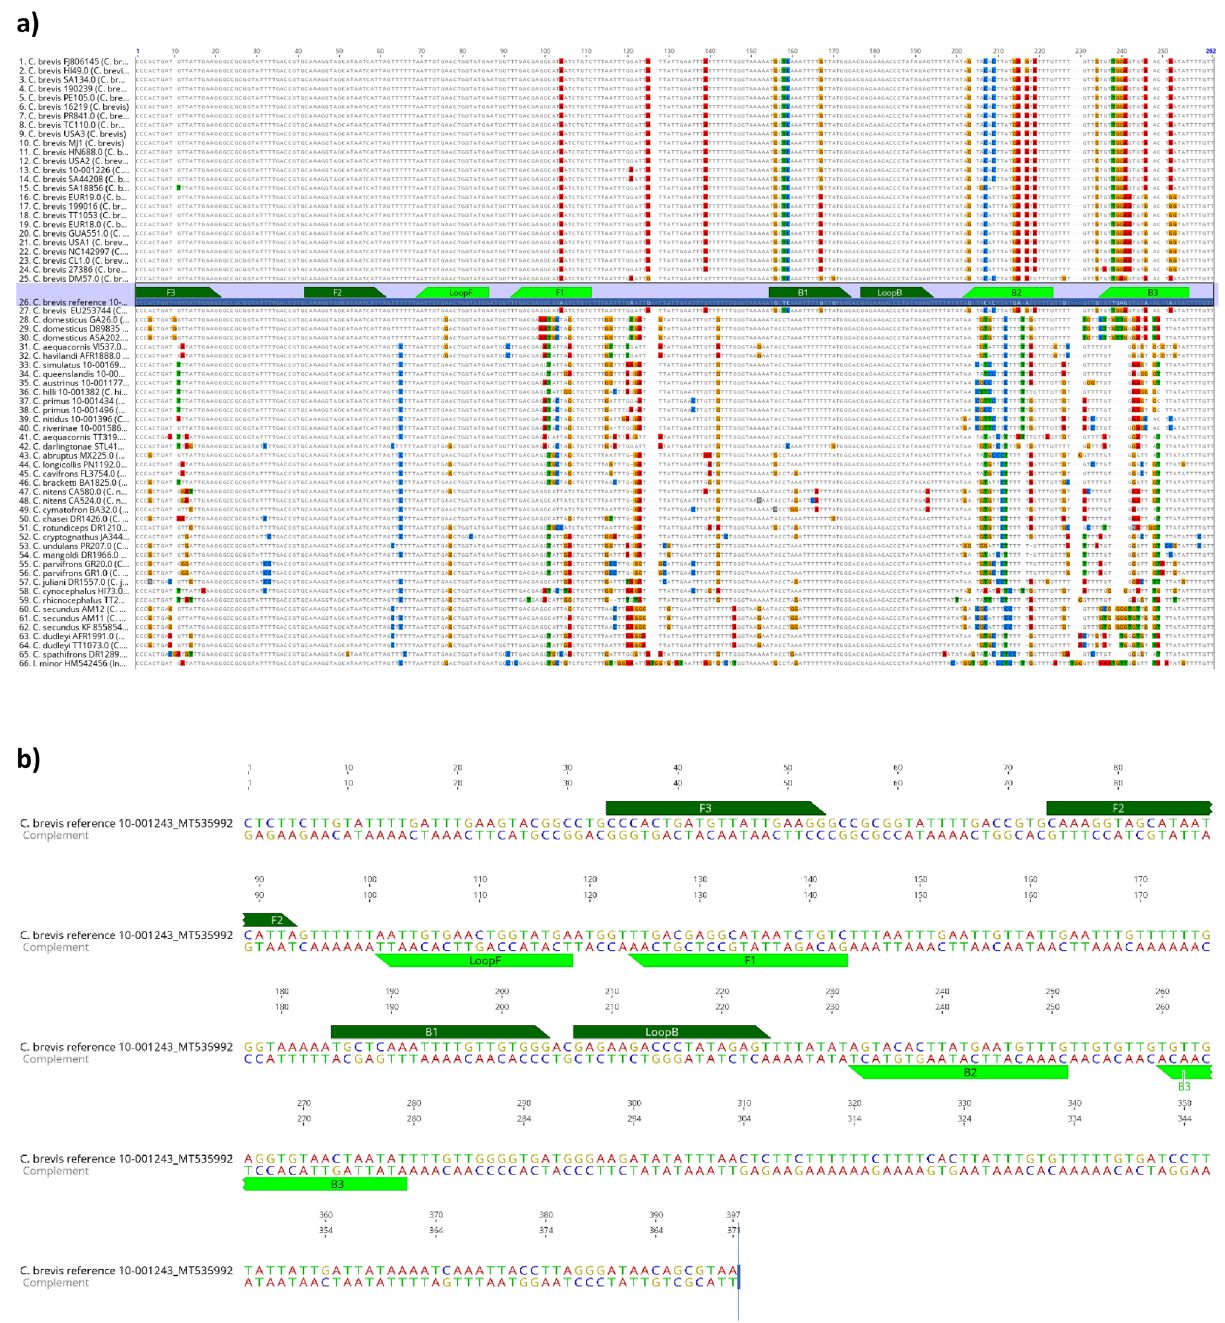
design. ( b ) The reference sequence C. brevis MT535992. Inner primer, FIP, consists of F1 (complementary sequences) and F2. Another inner primer, BIP, is also composed of B1 and B2 (complementary sequences); F3, forward outer primer; B3, reverse outer primer; LB, loop backward; LF, loop forward. Primer information is documented in Table